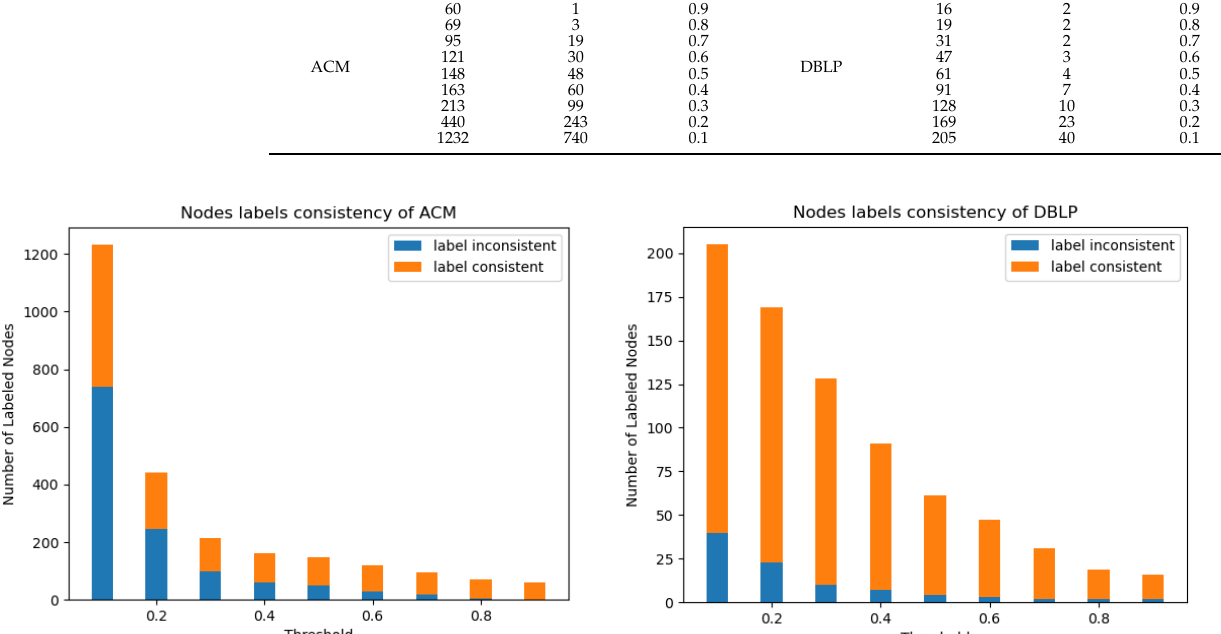
Figure 8. Histogram of node labels consistency on ACM ( Left ) and DBLP ( Right ) datasets under trace